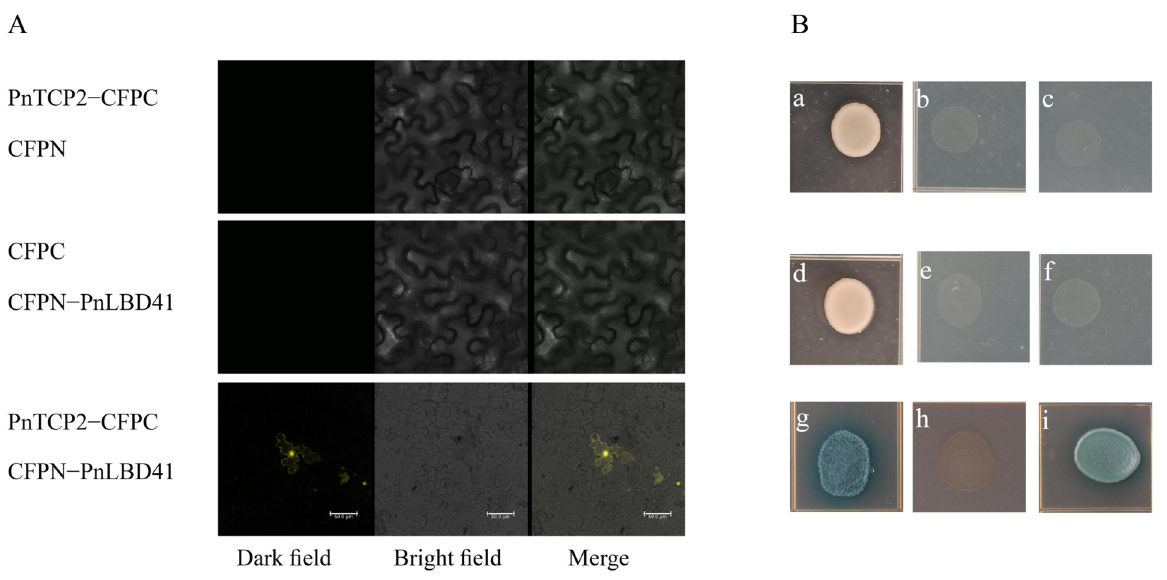
Figure 5. Verification of the protein interaction. ( A ) BiFC verification of the interaction between related proteins. ( B ) Yeast two-hybrid verification of the interaction between related proteins. Note: ( A ) PnTCP2 and PnLBD41 protein interactions. ( B ) (a) Yeast strain Y2H containing the pGBKT7-